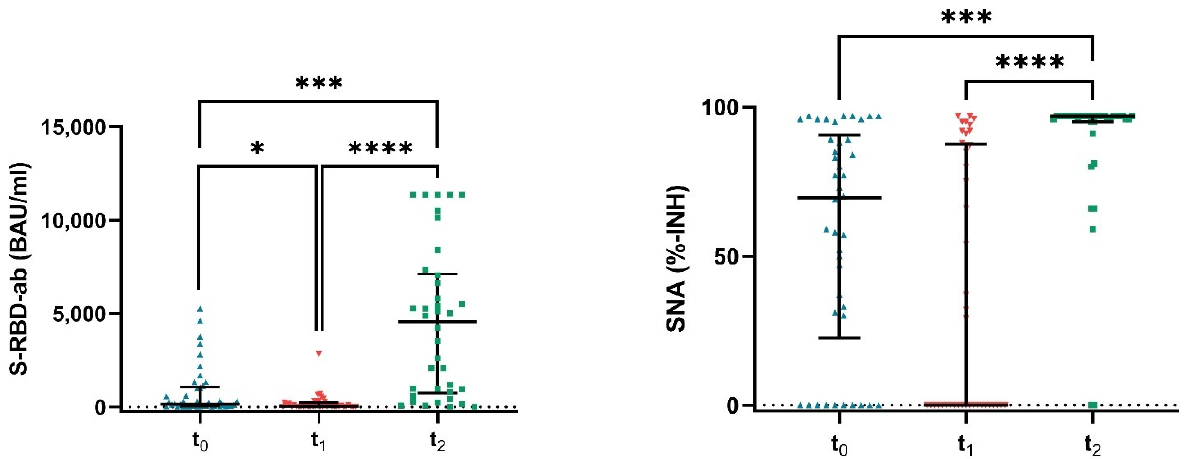
Figure 2. Antibody response in plasma samples of patients taken at three different time points (t 0 = four weeks after second dose, t 1 = six months after second dose and t 2 = 14 days after third dose (=booster vaccine) of mRNA-1273 (Moderna)). Abbreviations: S-RBD-ab (spike receptor binding domain-antibodies); SNA (surrogate neutralizing antibodies). Data are expressed as median (IQR). * p ≤ 0.05, *** p ≤ 0.001, **** p ≤ 0.0001 (Friedman